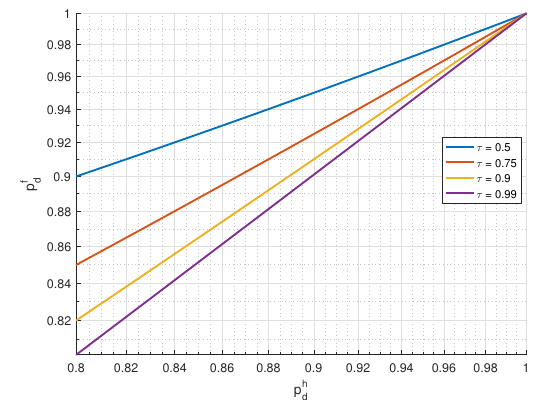
in terms of p h d